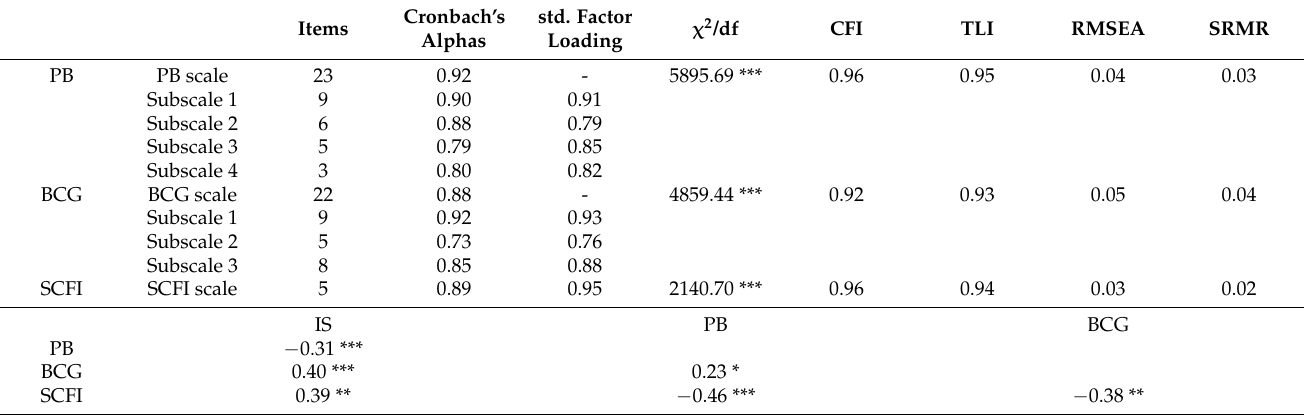
Table 2. The results of CFA and its